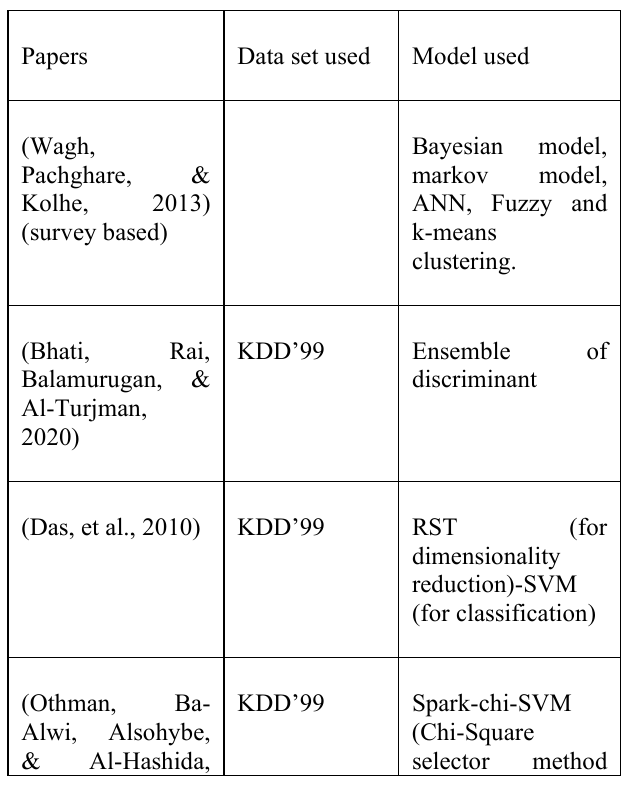
Table 1. Summary of papers related to